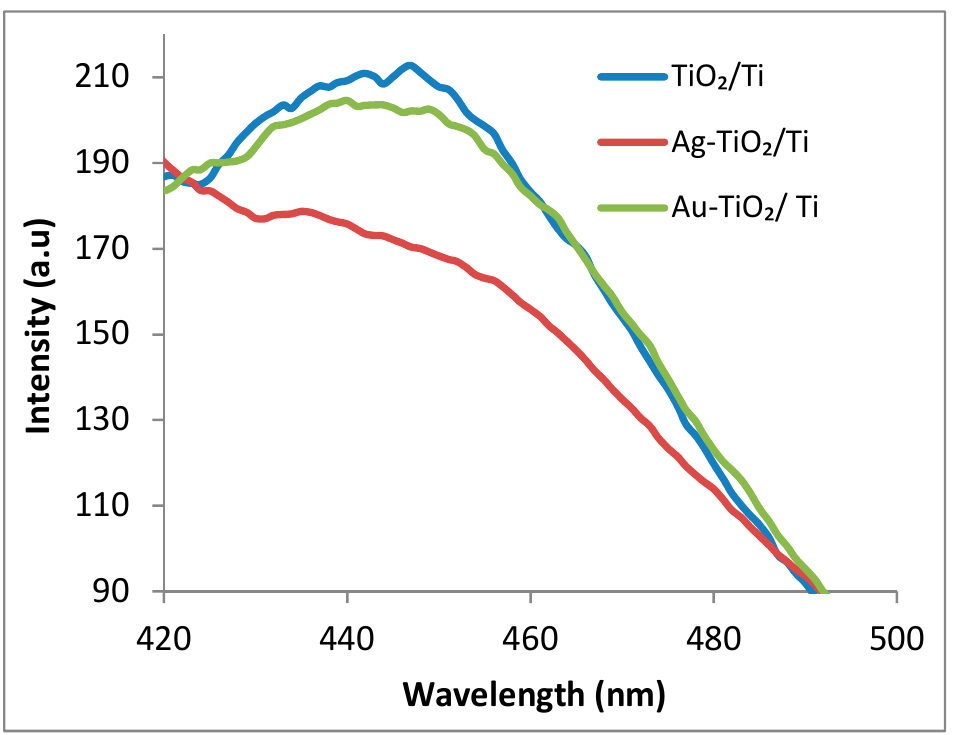
Figure 10. Fluorescence spectra of the released 7-hydroxy-4-metylcoumarin in buffer solution ( λ exc = 355 nm, λ em = 450 nm) after 3 h of reaction.